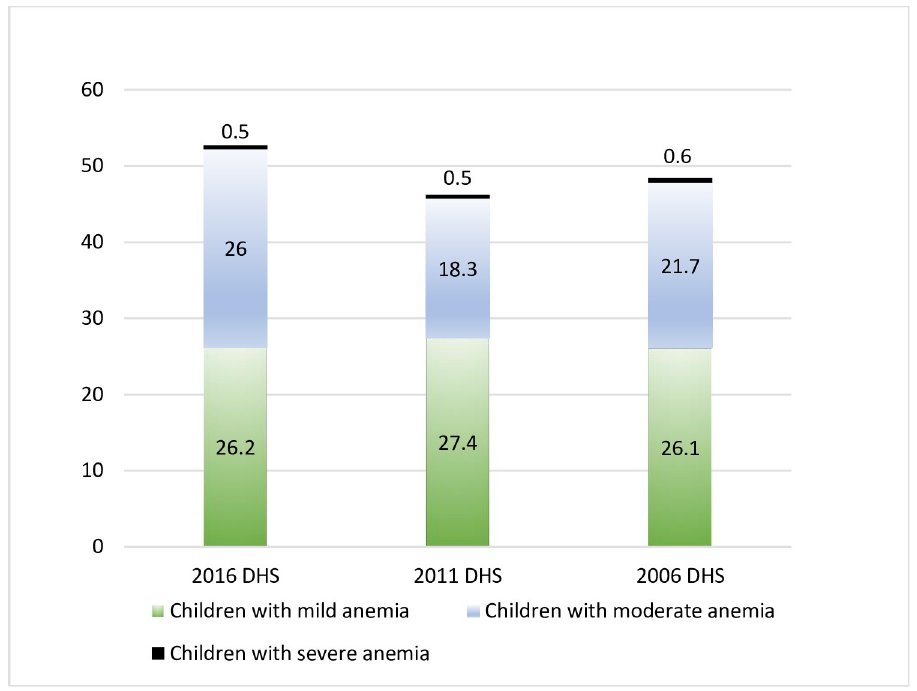
Fig 3. Trend of prevalence for childhood anemia from 2006 to 2016 in